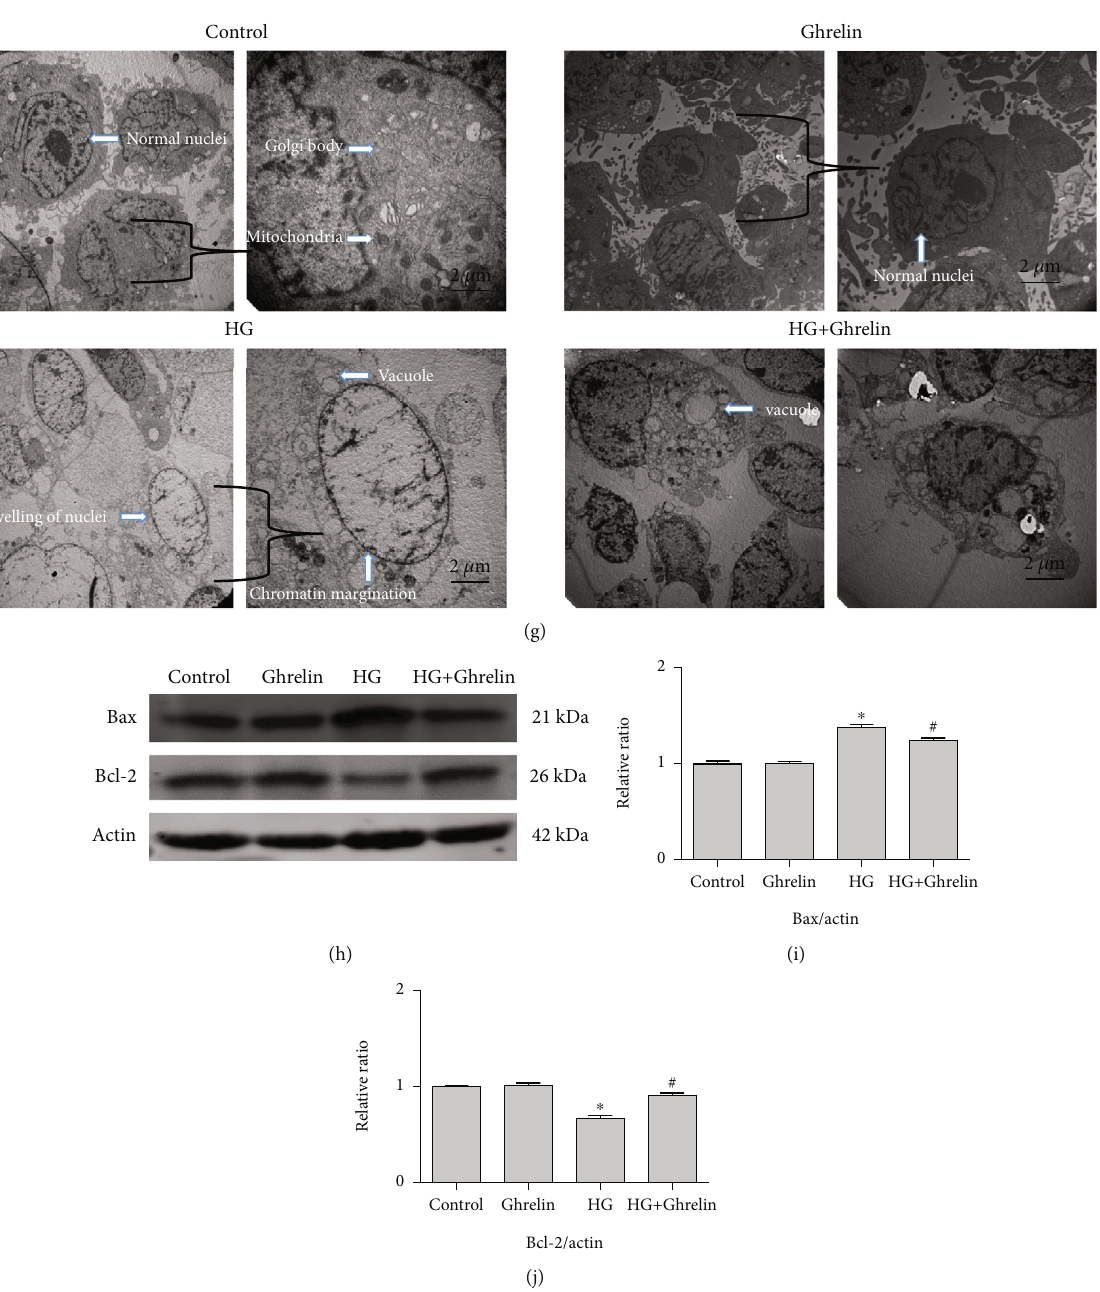
Figure 3: Ghrelin inhibited HG-induced HLE cell apoptosis. HLE cells were incubated with ghrelin (0.1 μ M) for 2 h and then exposed to HG for 24h. (a) The number of trypan-positive cells was quanti fi ed, and at least 100 cells per dish were counted. (b) Quantitative analyses of the apoptosis rate in HLE cells. (c) AO/EB double stain of HLE cells after a treatment with ghrelin. (d) Quantitative analyses of the apoptosis rate in HLE cells. (e) Flow cytometric analysis was used to detect apoptosis rate. (f) Quantitative analyses of the apoptosis rate. (g) Ultrastructural changes in HLE cells induced by HG using transmission electron microscopy. (h) The expressions of Bax and Bcl-2 were detected by Western blot. (i) Quantitative analysis of Bax expression intensity relative to actin. (j) Quantitative analysis of Bcl-2 expression intensity relative to actin. ∗ P < 0 : 05 vs. control group; # P < 0 : 05 vs. HG